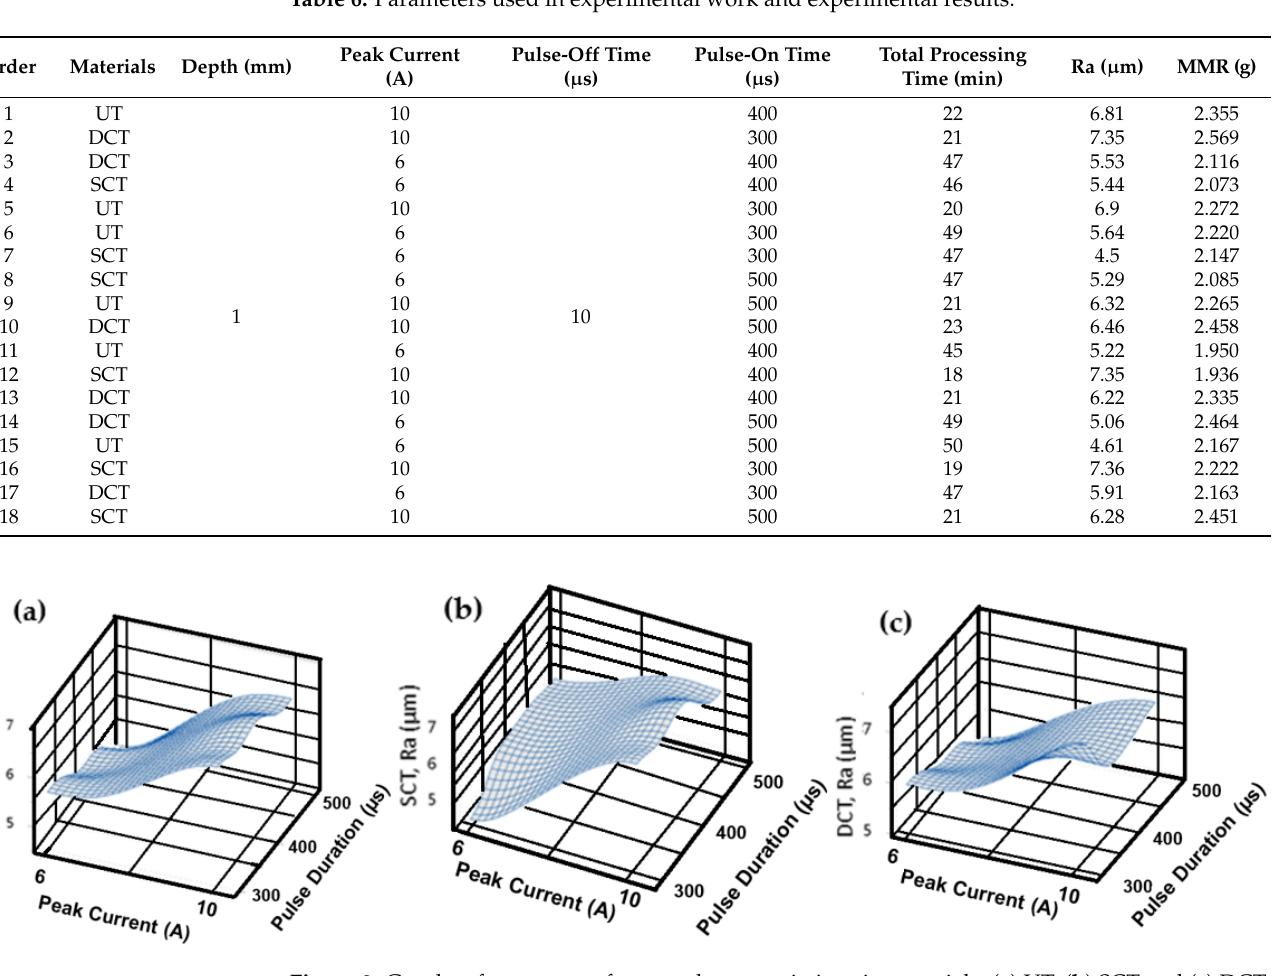
Table 5. Properties of the electrode material.